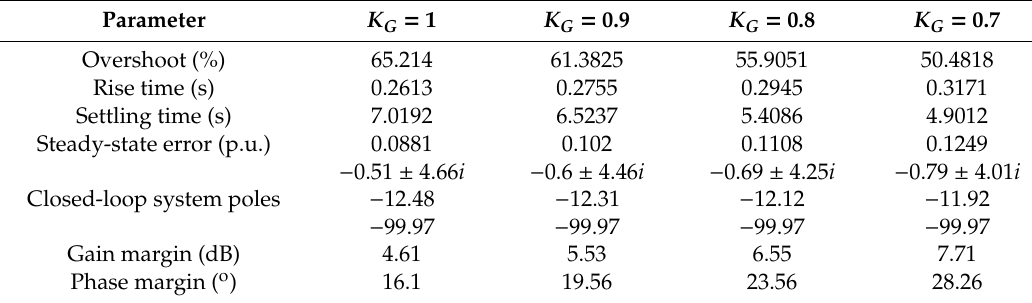
Table 2. Values of the transient response and frequency response parameters.